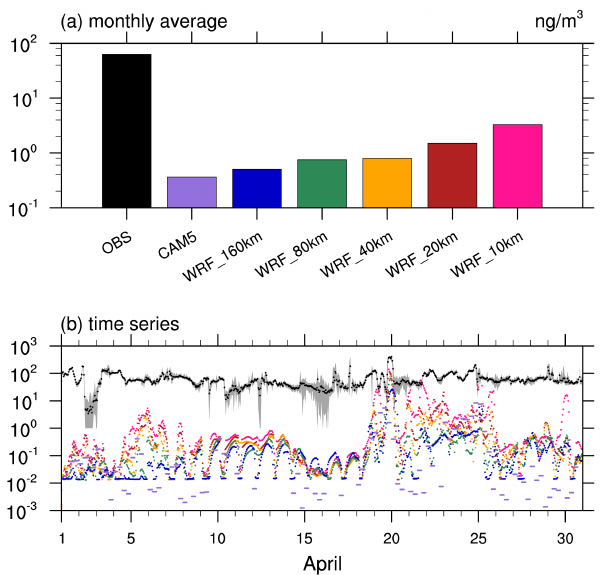
Fig. 7. Surface black carbon concentration (ngm − 3 ) over Barrow from model simulations and PSAP measurements: (a) monthly av- erage and (b) time series.